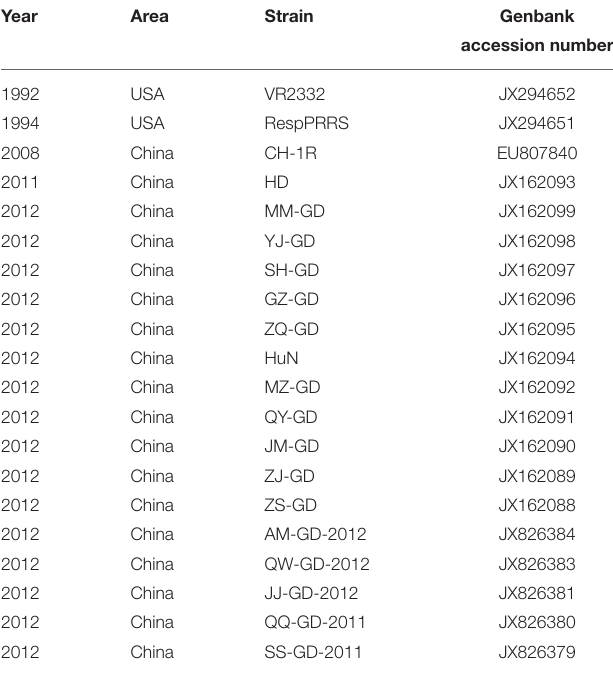
TABLE 1 | Reference sequences of 20 PRRSV NSP9 strains.